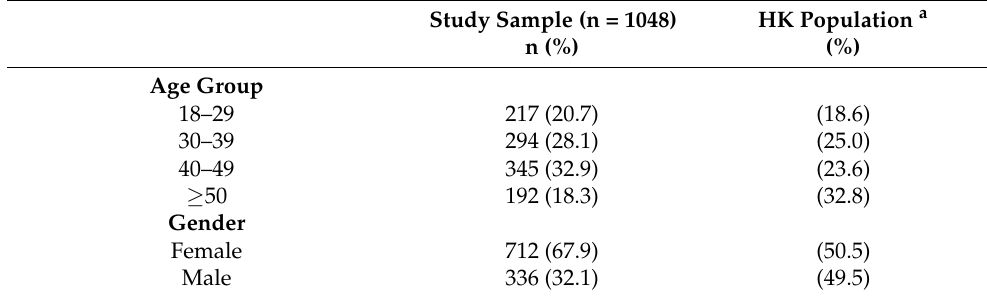
Table 1. Characteristics of the sample